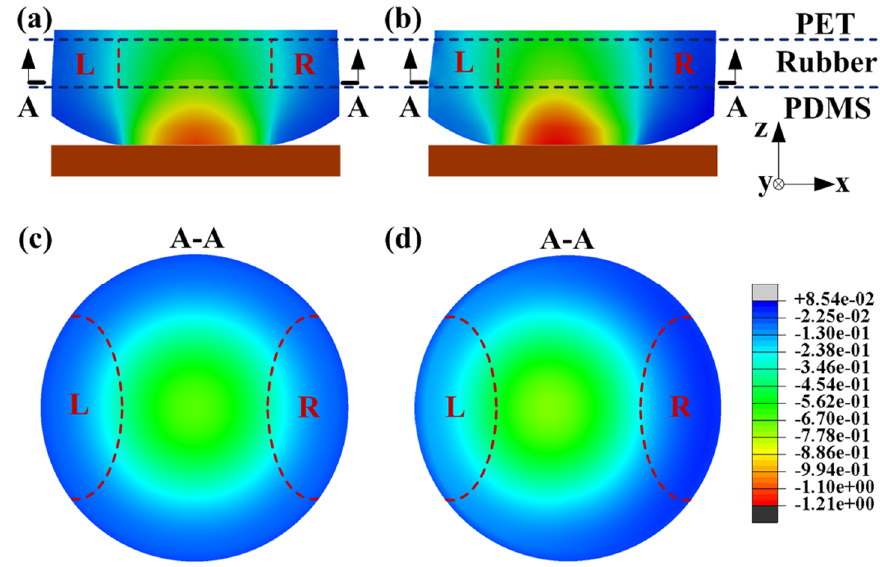
Figure 5. The stress distribution in the cross-section view of the sensing unit at the end of ( a ) compress and ( b ) sliding. A-A cross-section at the end of ( c ) compress and ( d )